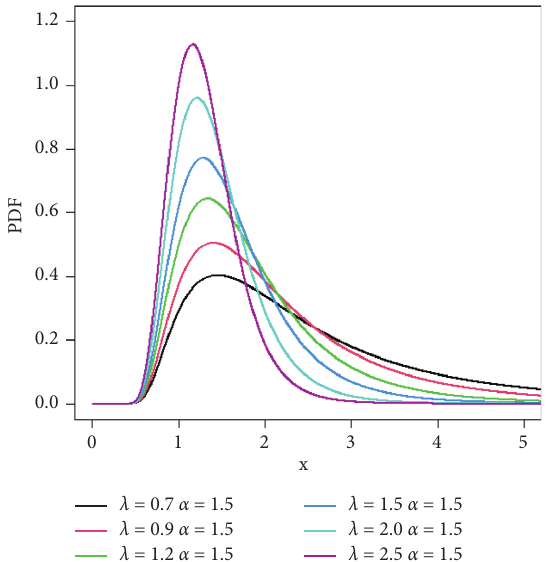
Figure 1: PDF plots for SHLIR distribution.